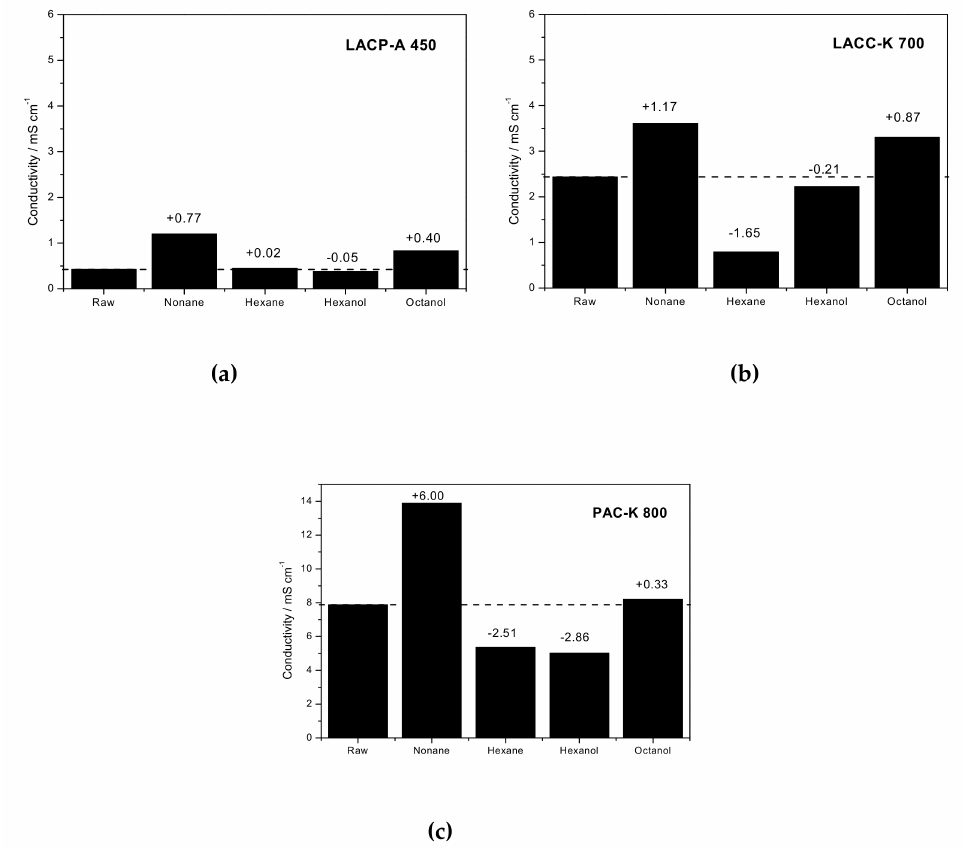
Figure 6. Electrical conductivity (mS / cm) measured for the three activated carbons: ( a ) LACP-A 450; ( b ) LACC-K 700 and ( c ) PAC-K 800, evaluated before (raw) and after adsorption of di ff